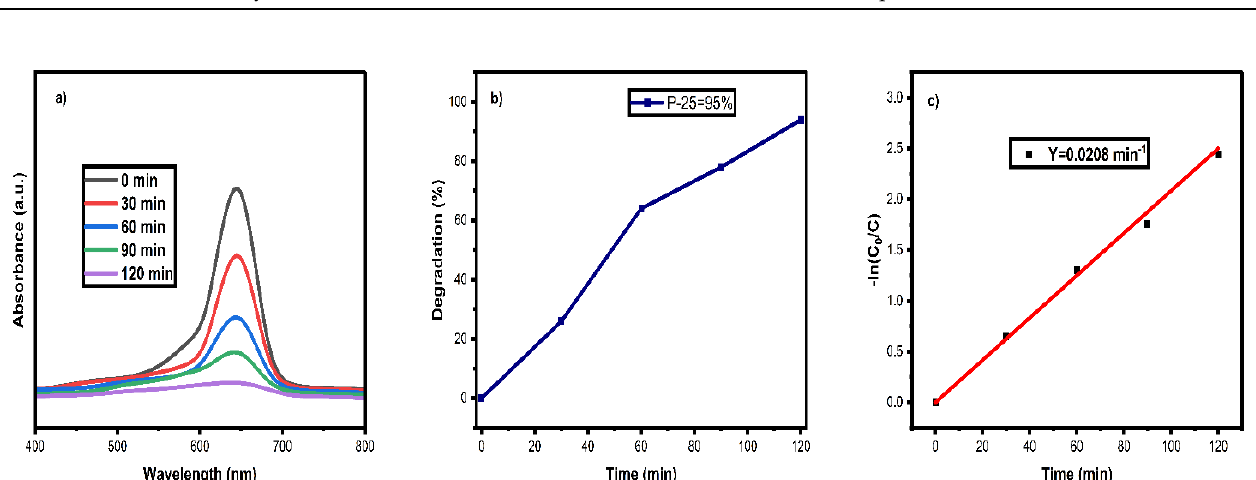
Figure 10. ( a ) P25 Photocatalyst degradation spectrum, ( b ) degradation efficiency graph, and ( c ) kinetic spectrum. Table 1. Photocatalytic comparison table of biosynthesized CoFe 2 O 4 nanoparticles.